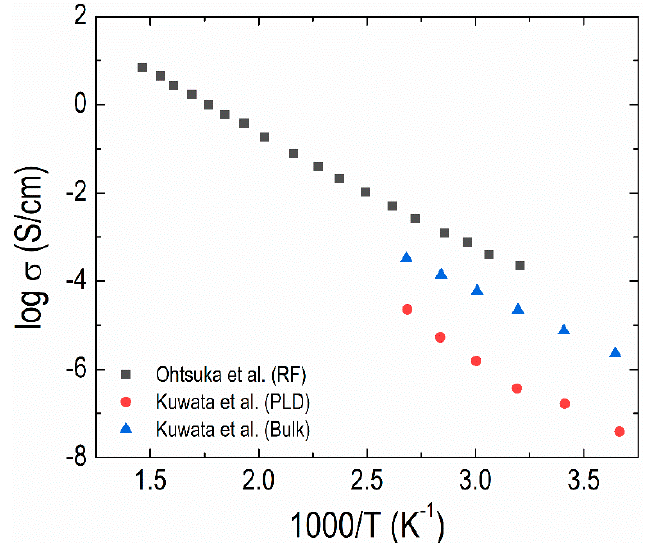
Figure 12. Conductivity summary of bulk [405] and thin-film Li 2 O–V 2 O 5 –SiO 2 (LVSO) deposited via PLD [404,405] and RF sputtering [319].